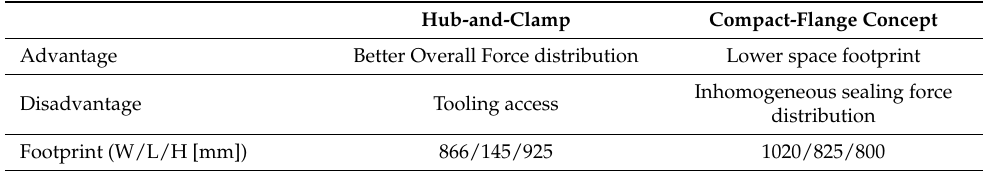
Table 2. Comparison between two concept